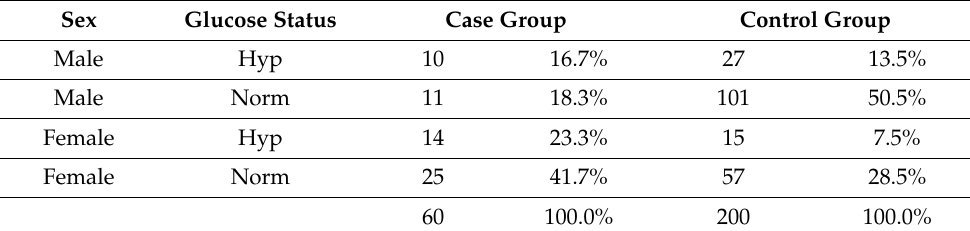
Table 1. Prevalence of hyperglycemia and normoglycemia both in the case and in the control groups. Sex Glucose Status Case Group